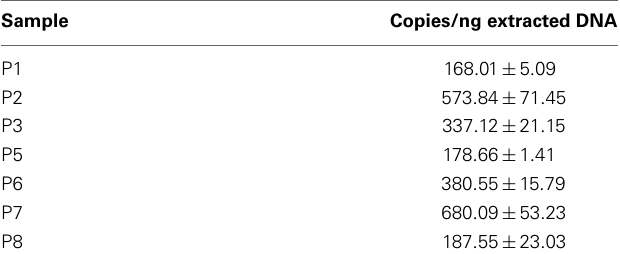
Table 4 | Quantification results of the single-copy β -actin gene for the detection of fungal cells on parchment samples by